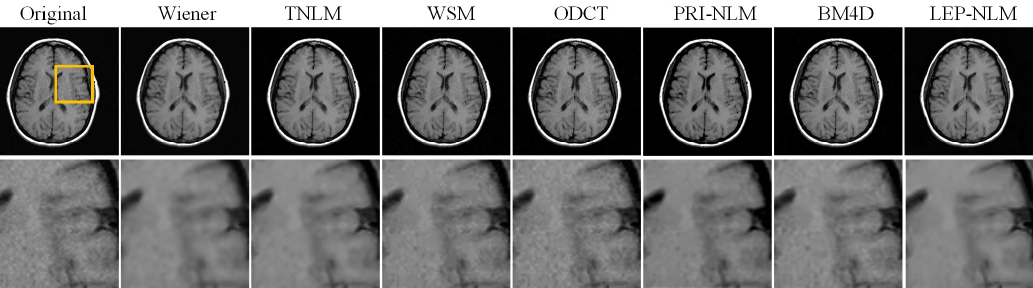
Figure 7. The restoration results of a real T1-weighted brain MR image by the various denoising filters. From top to bottom: the original MR images and the corresponding enlarged portions of ROIs marked with the yellow box in the original images.